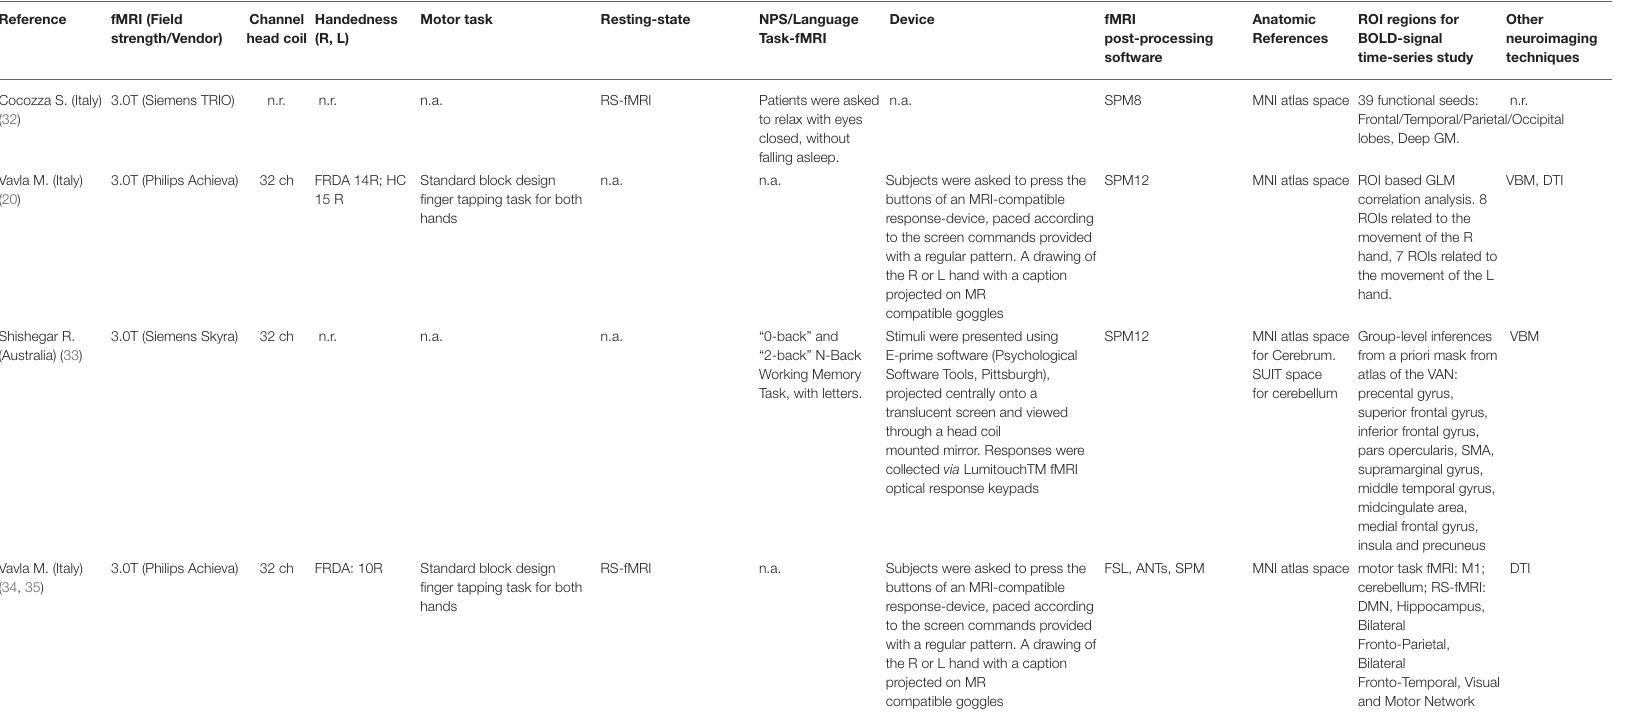
Right,R;L,Left;FRDA,Friedreich’sataxia;HCs,healthycontrols;NPS,neuropsychological,Fmri,functionalMRI;SPECT,single-photonemissionCT;DTI,diffusiontensorimaging;VBM,voxel-basedMorphometry;RS-fMRI,resting-state fMRI; SWI, susceptibility-weighted images; MNI, Montreal Neurological Institute; GLM, general linear model; DMN, default mode network; ROI, region of interest; BOLD, blood oxygenation level dependent; SPM, Statistical parametric mapping; M1, primary motor; SMA, sensorimotor area; BG, Basal Ganglia; iPL, inferior parietal lobe; DN, dentate nuclei; ACC, anterior cingulated cortex; BA, Brodmann area; VAN, ventral attention network; GM, gray matter; n.a, not applied; n.r., not